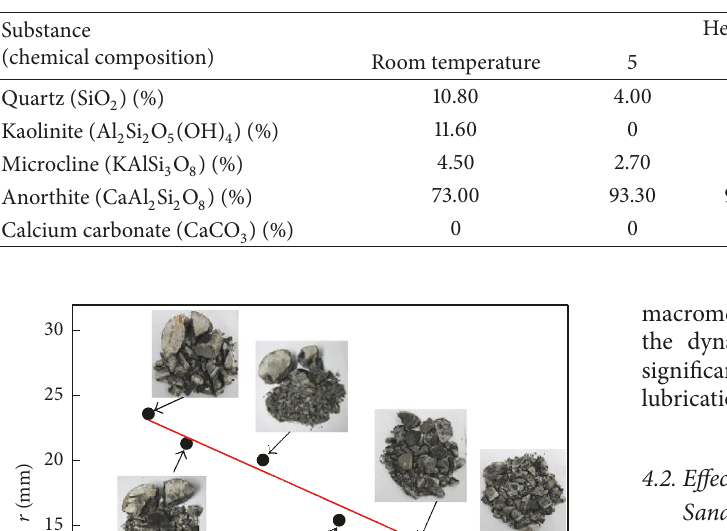
Table 4: Main components of sandstone.